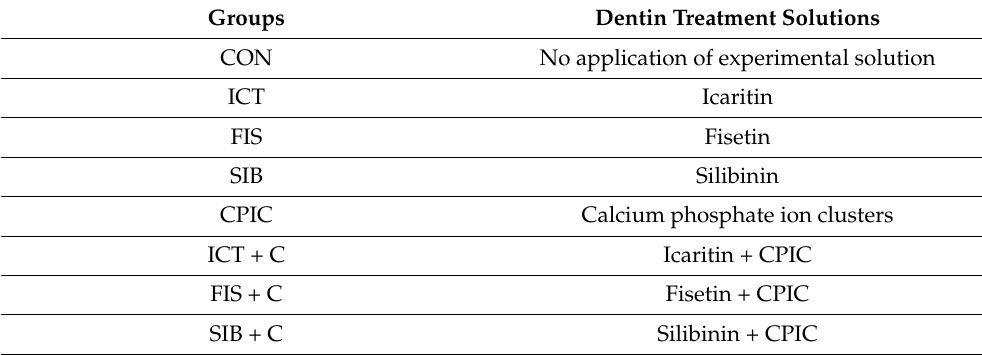
Table 3. Experimental groups used in this